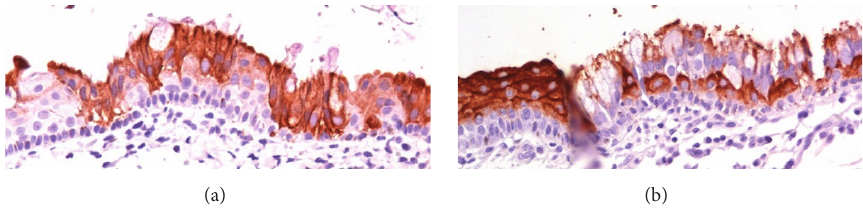
Figure 5: (a) The cytokeratin 7 staining is positive in columnar cells but negative for basal cells and squamous metaplastic cells (400x). (b) The immunohistochemical result of carcinoembryonic antigen (CEA) is the opposite (400x).